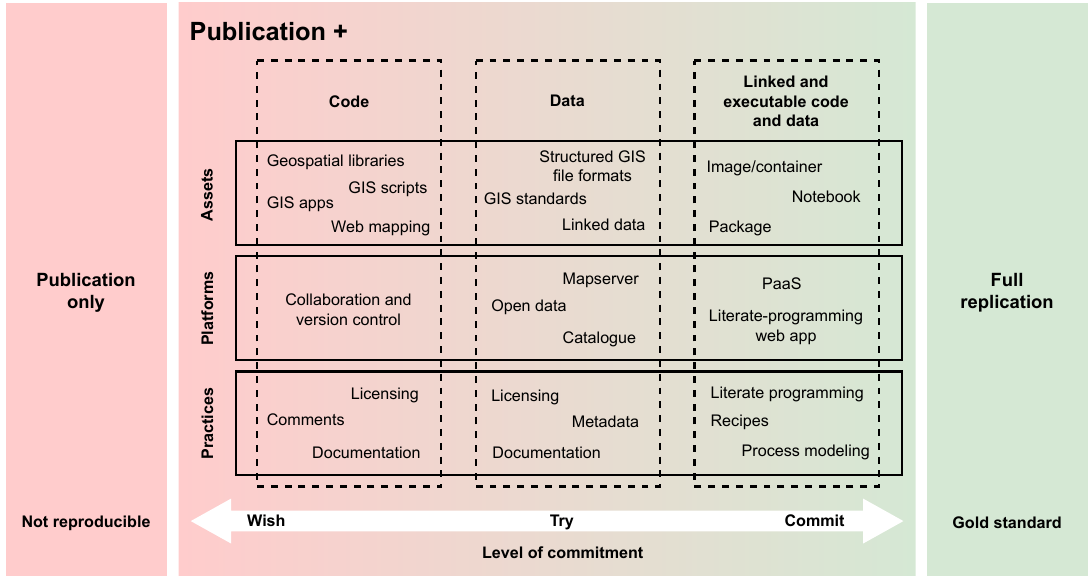
Figure 2. An Open Reproducible Research spectrum in the field of GISciences. Note: the relationships between the elements in the core of the diagram are not defined, so these will vary according to the needs of each